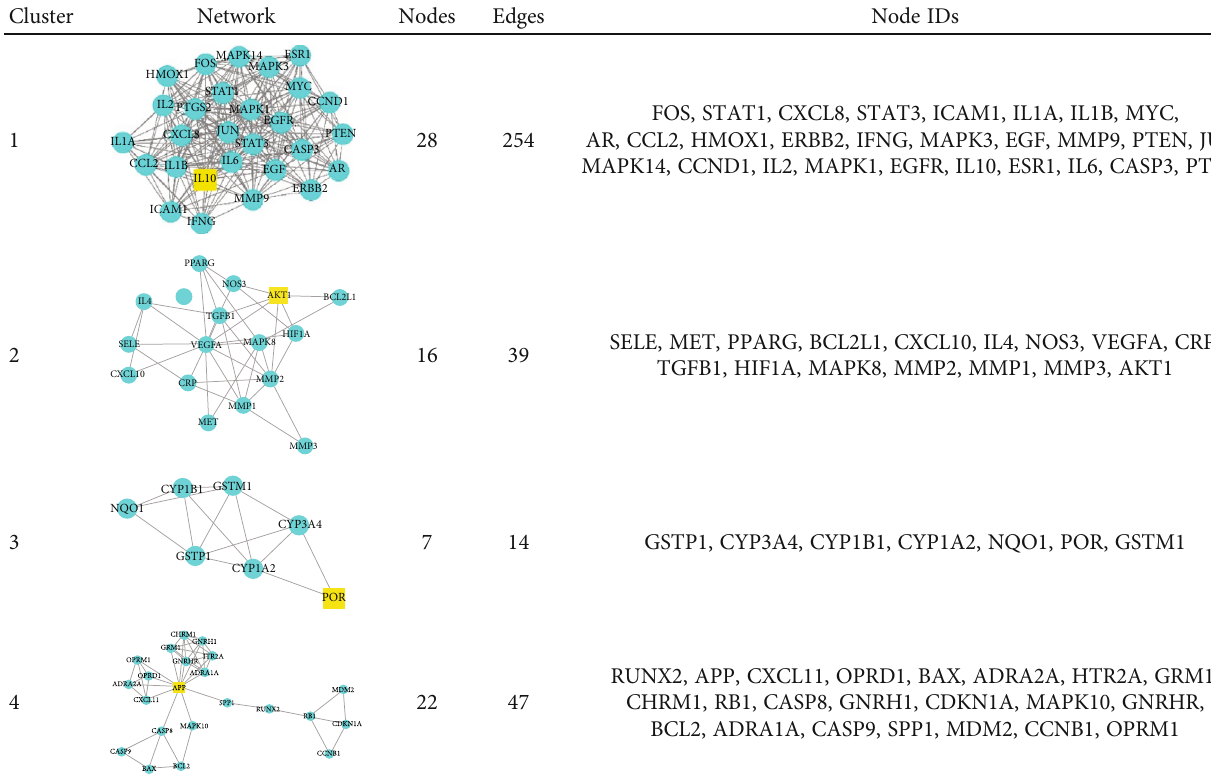
Table 2: Cluster analysis based on Molecular Complex